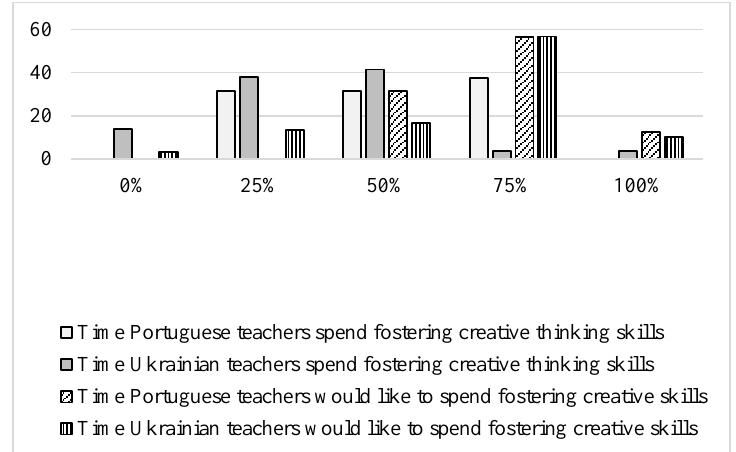
Fig. 5. Comparison of time spent on fostering creative thinking